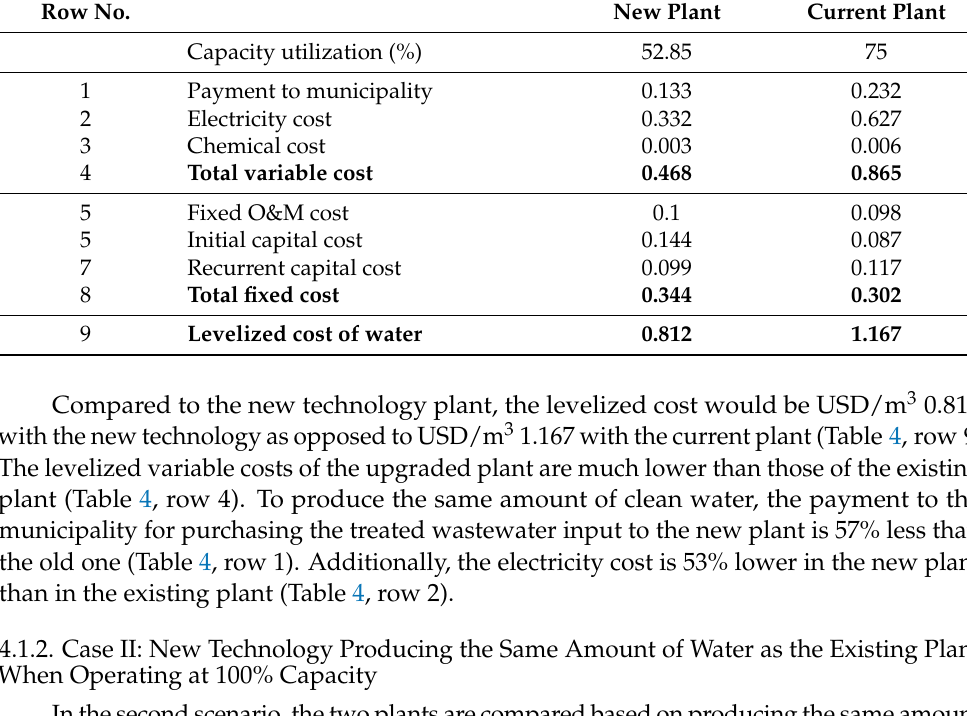
Table 4. Levelized financial costs of 2,042,670 m 3 of clean water in 2022 prices, USD/m 3 . Row